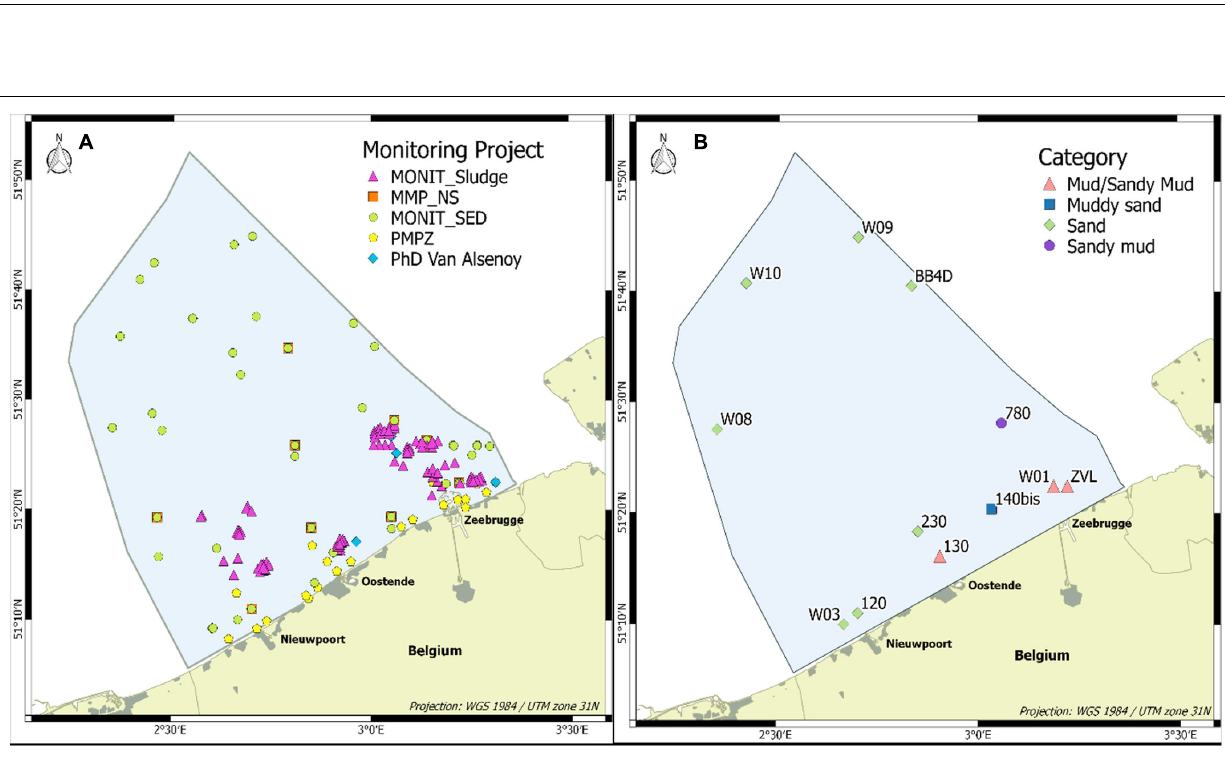
FIGURE 2 | (A) Overview of all sampling locations of the main dataset DS1 (1971–2015). (B) Overview of samples of DS3 used as equally polluted samples in the co-factor analysis (March 2015) and the pure sand samples (W08, W09, W10) of DS4 used for background normalization constant determination